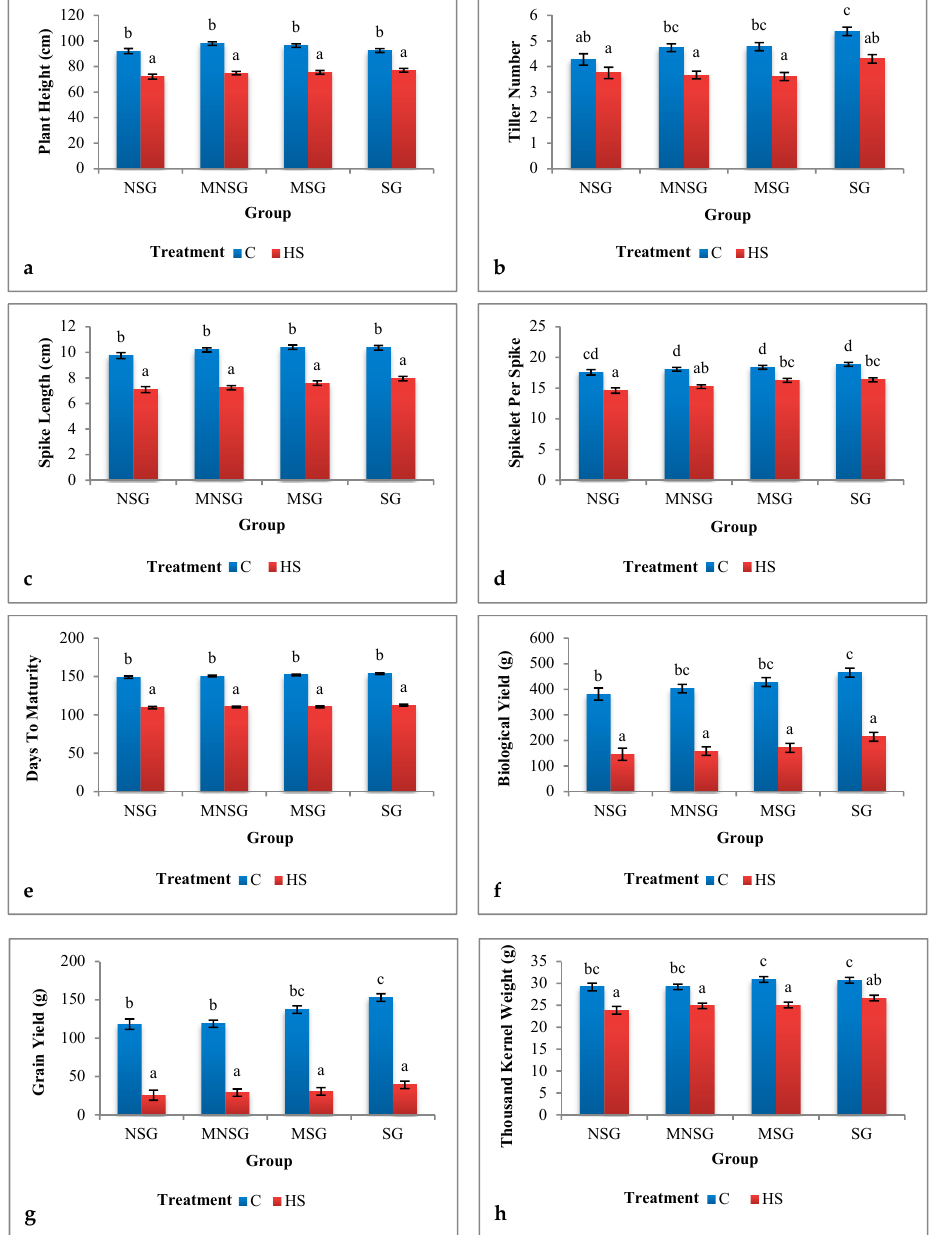
Figure 5. Variation in the morphological traits between the non-stay-green (NSG), moderately non-stay-green (MNSG), moderately stay-green (MSG), and stay-green (SG) groups under control (C) and heat stress (HS) conditions. ( a ) Plant height; ( b ) tiller number; ( c ) spike length; ( d ) spikelet per spike; ( e ) days to maturity; ( f ) biological yield; ( g ) grain yield; and ( h ) thousand kernel weight. Bars represent the least square means from the 2014–2015 and 2015–2016 field experiments. Error bars depict the standard errors and different lowercase letters representing significant differences among the groups and treatments at p < 0.05.